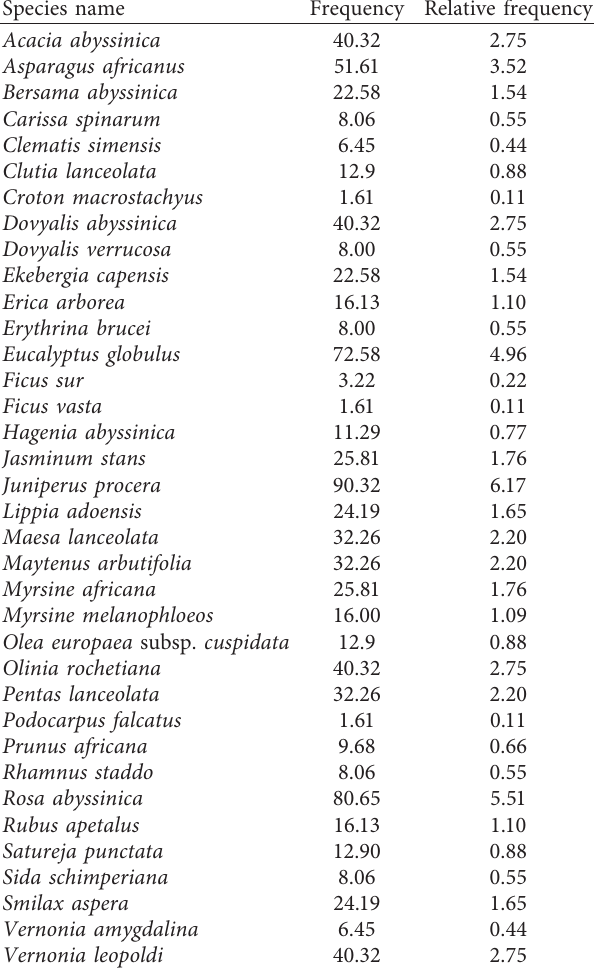
Table 5: Frequency and relative frequency of selected